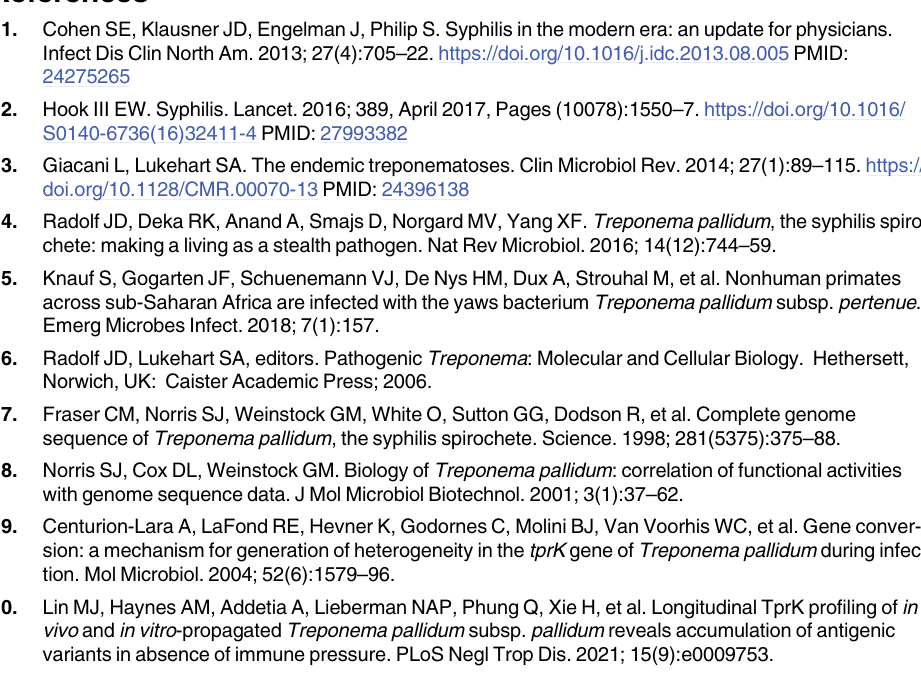
S2 Table. Polynucleotide length differences in T. pallidum Nichols